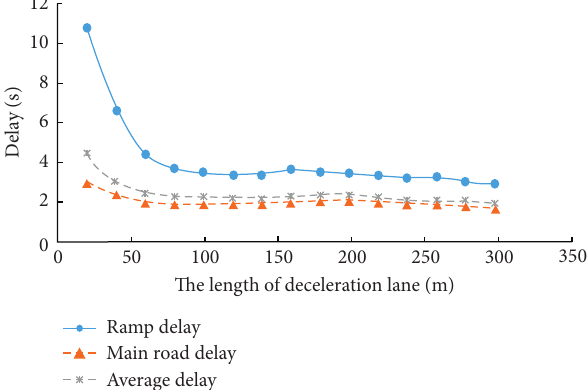
Figure 6: The relationship between delay and the length of the acceleration